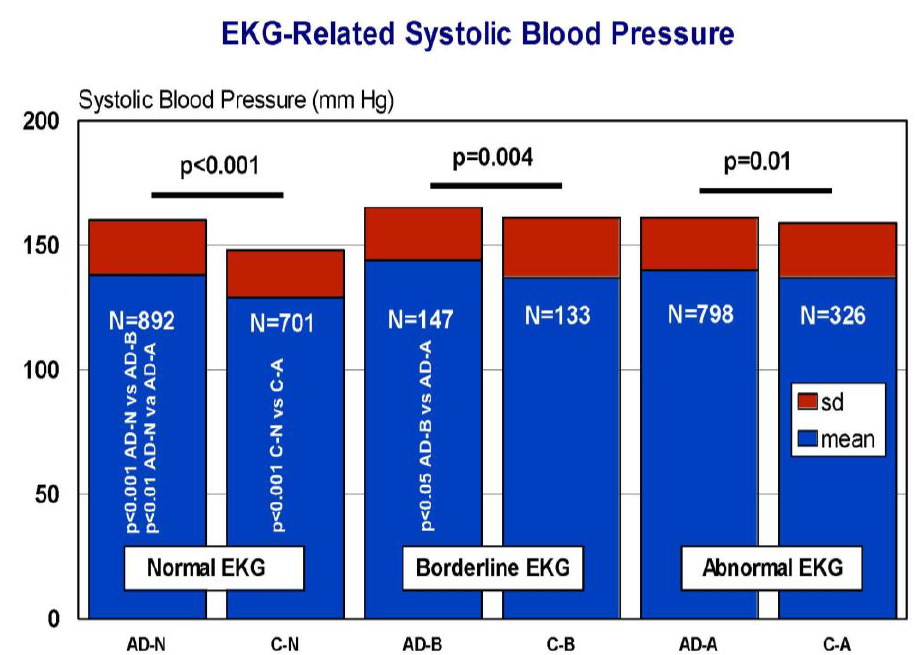
Figure 19. Electrocardiogram (EKG)-related systolic blood pressure in patients with Alzheimer’s disease and controls. AD: Alzheimer’s disease. C: Control. N: Normal. B: Borderline. A: Abnormal. AD-N vs. AD-B, p < 0.001; AD-N vs. AD-A, p < 0.01; C-N vs. C-A, p < 0.001; AD-B vs. AD-A, p > 0.05.